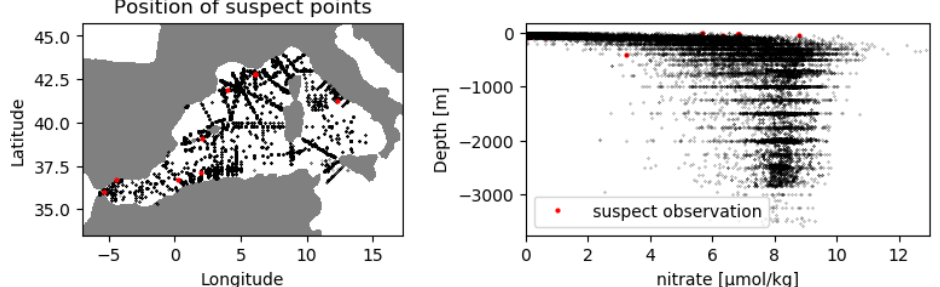
Figure B3. Position of the suspect points (nitrate climatology, 1981–2017).